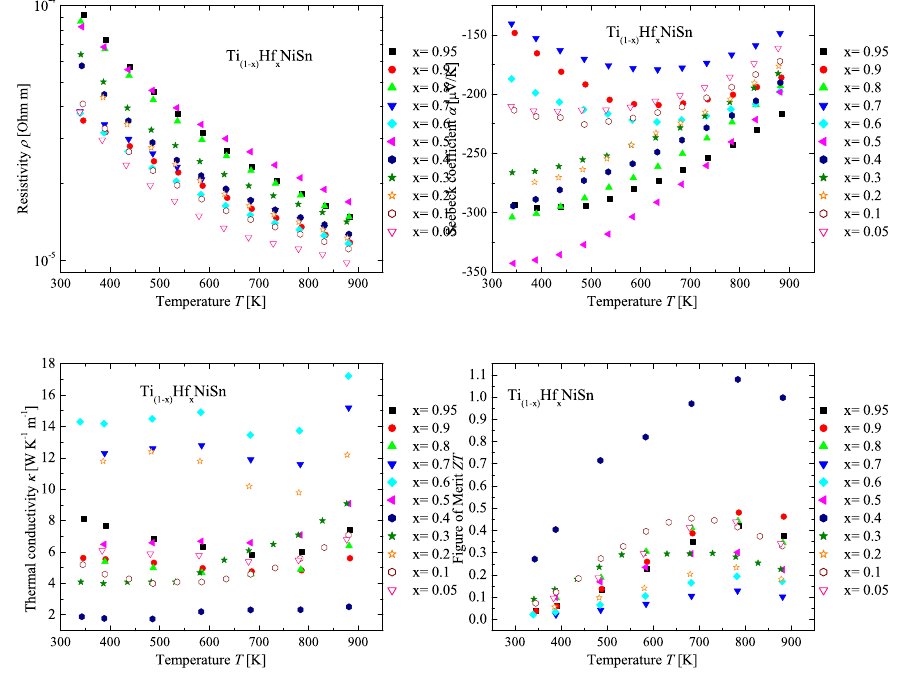
Figure 9. Electrical resistivity ( top left ), Seebeck coefficient ( top right ), thermal conductivity ( bottom left ) and figure of merit ( bottom right ) of the Ti ( 1 − x ) Hf x NiSn series in comparison to the parent compounds. 2.5. The Ti ( (Zr 0.5 Hf 0.5 ) x NiSn 1 − x )